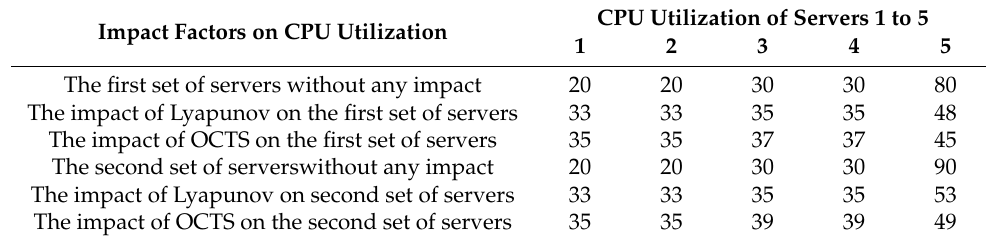
Figure 5. The communication architecture for SD-VEC. Table 2. Description of the simulation experimental parameters. Table 2. Description of the simulation experimental parameters.